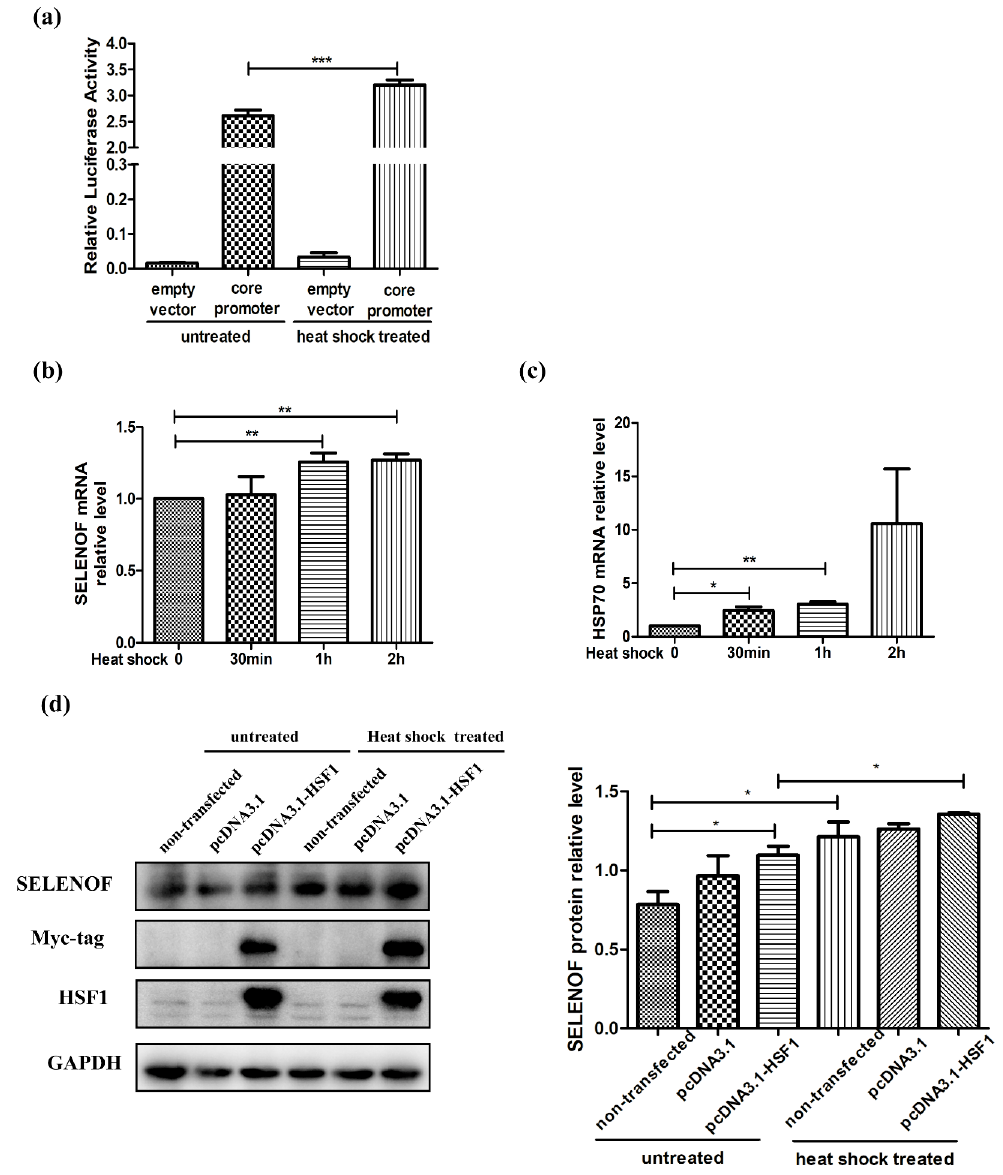
Figure 5. Heat shock treatment increased SELENOF transcriptional regulation. ( a ) Luciferase reporter activities of SELENOF core positive regulatory element in transfected HEK293T cells with /